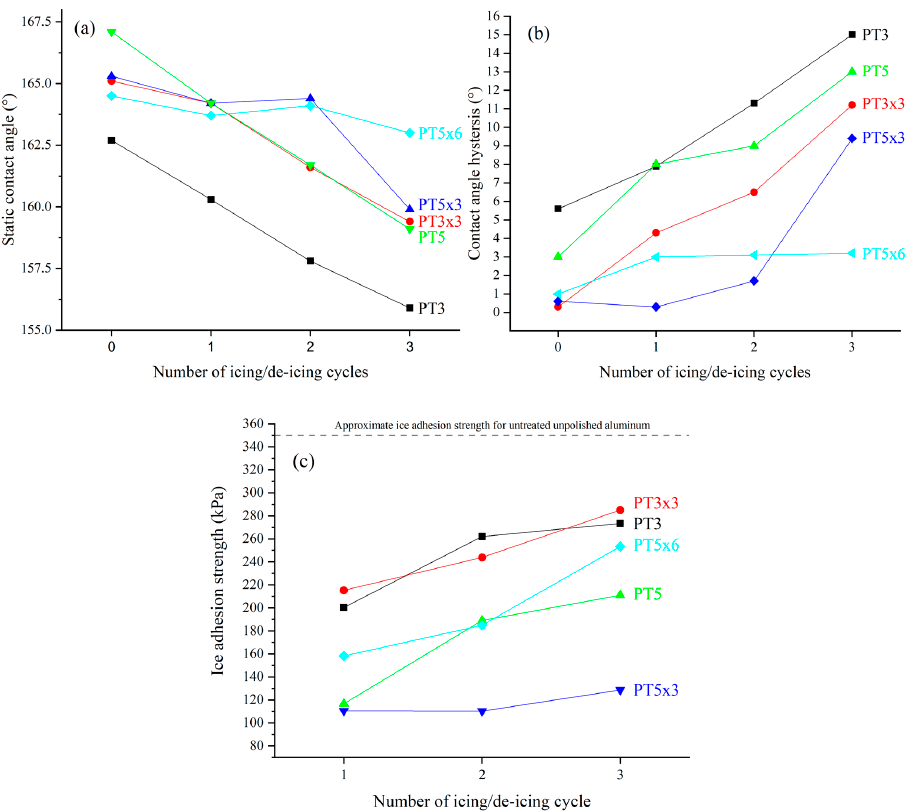
Figure 7. ( a ) Static contact angle, ( b ) contact angle hysteresis, and ( c ) ice adhesion strength for the first three icing/de-icing cycles for PT3, PT3x3, PT5, PT5x3, and